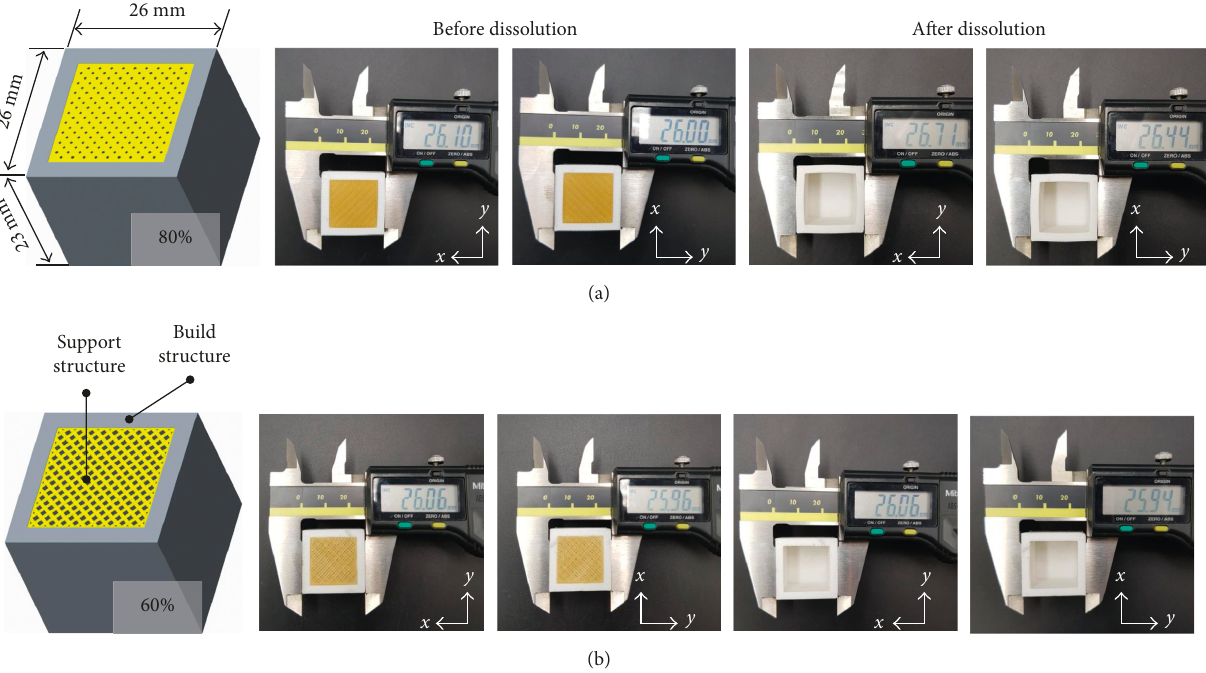
Figure 10: Evaluation of dimensional change before and after dissolution in two different specimens with (a) 80% and (b) 60% of support infill